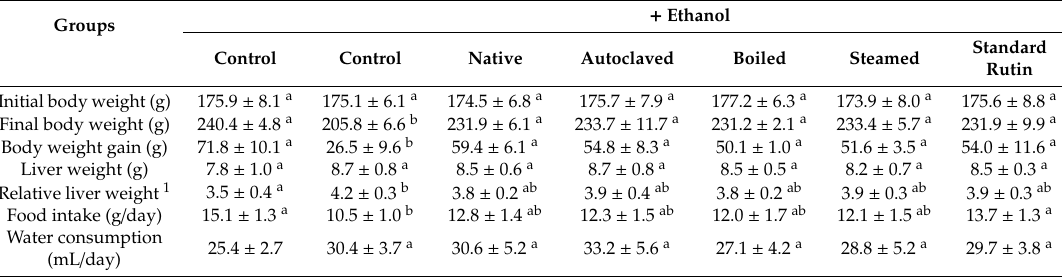
1 Relative liver weight was calculated by liver g / 100 g body